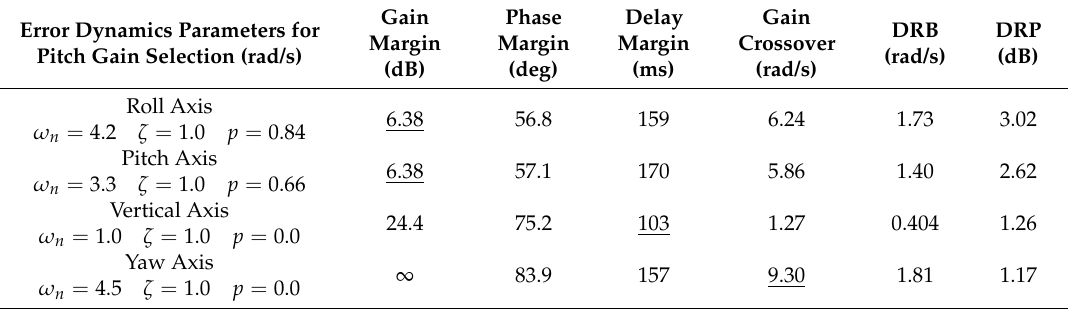
Table 6. Final controller performance with selected gains. The underlined parameters indicate the parameter that limits the gain used in each